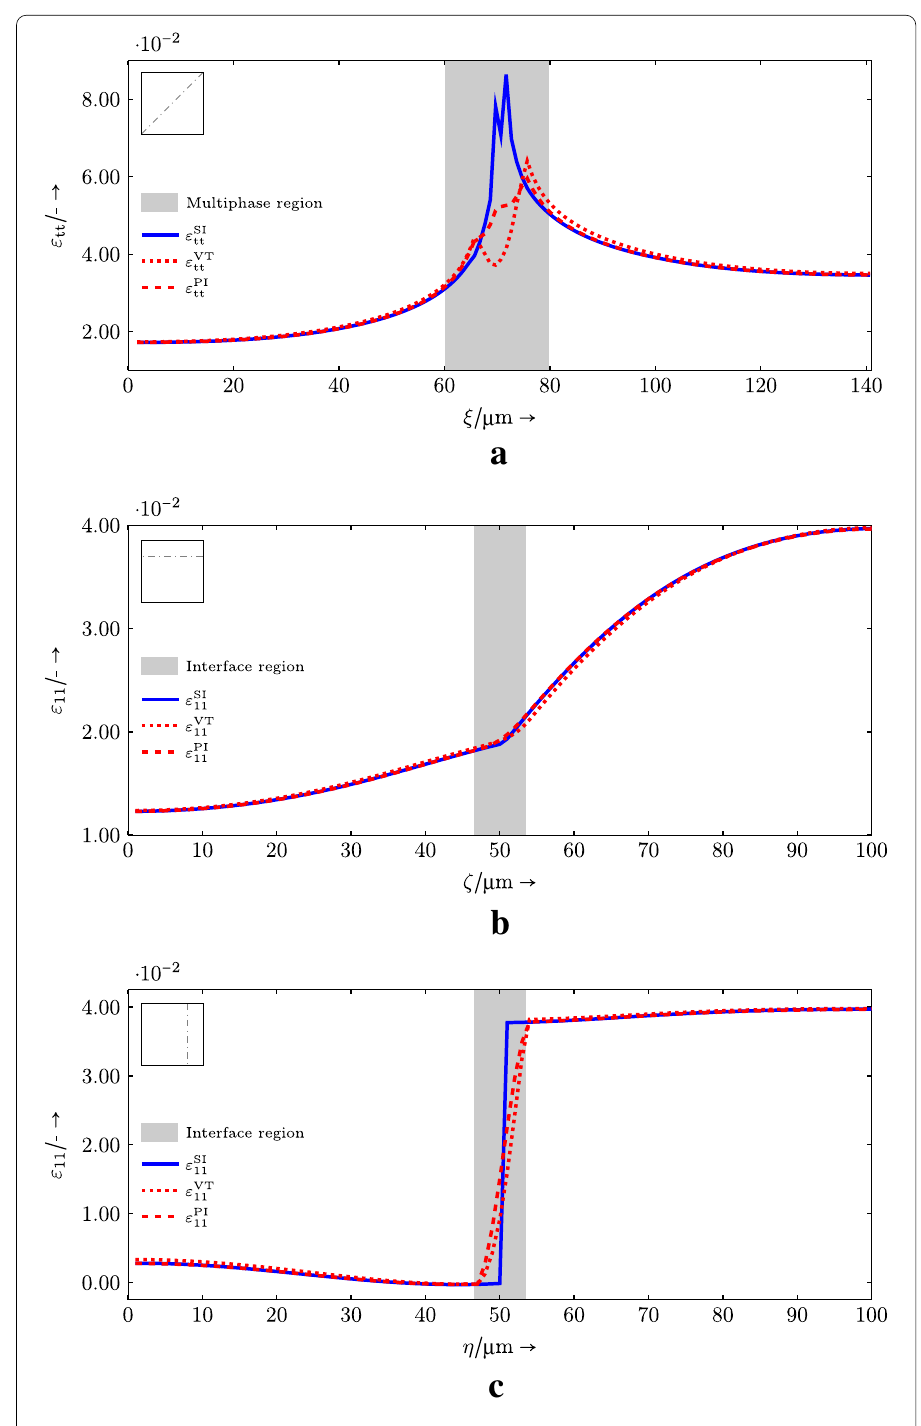
Fig. 17 Results for a ε tt and b, c ε 11 along ξ and ζ , η , respectively: Comparison of the VT and the PI approach to the sharp-interface solution after t = 10 .